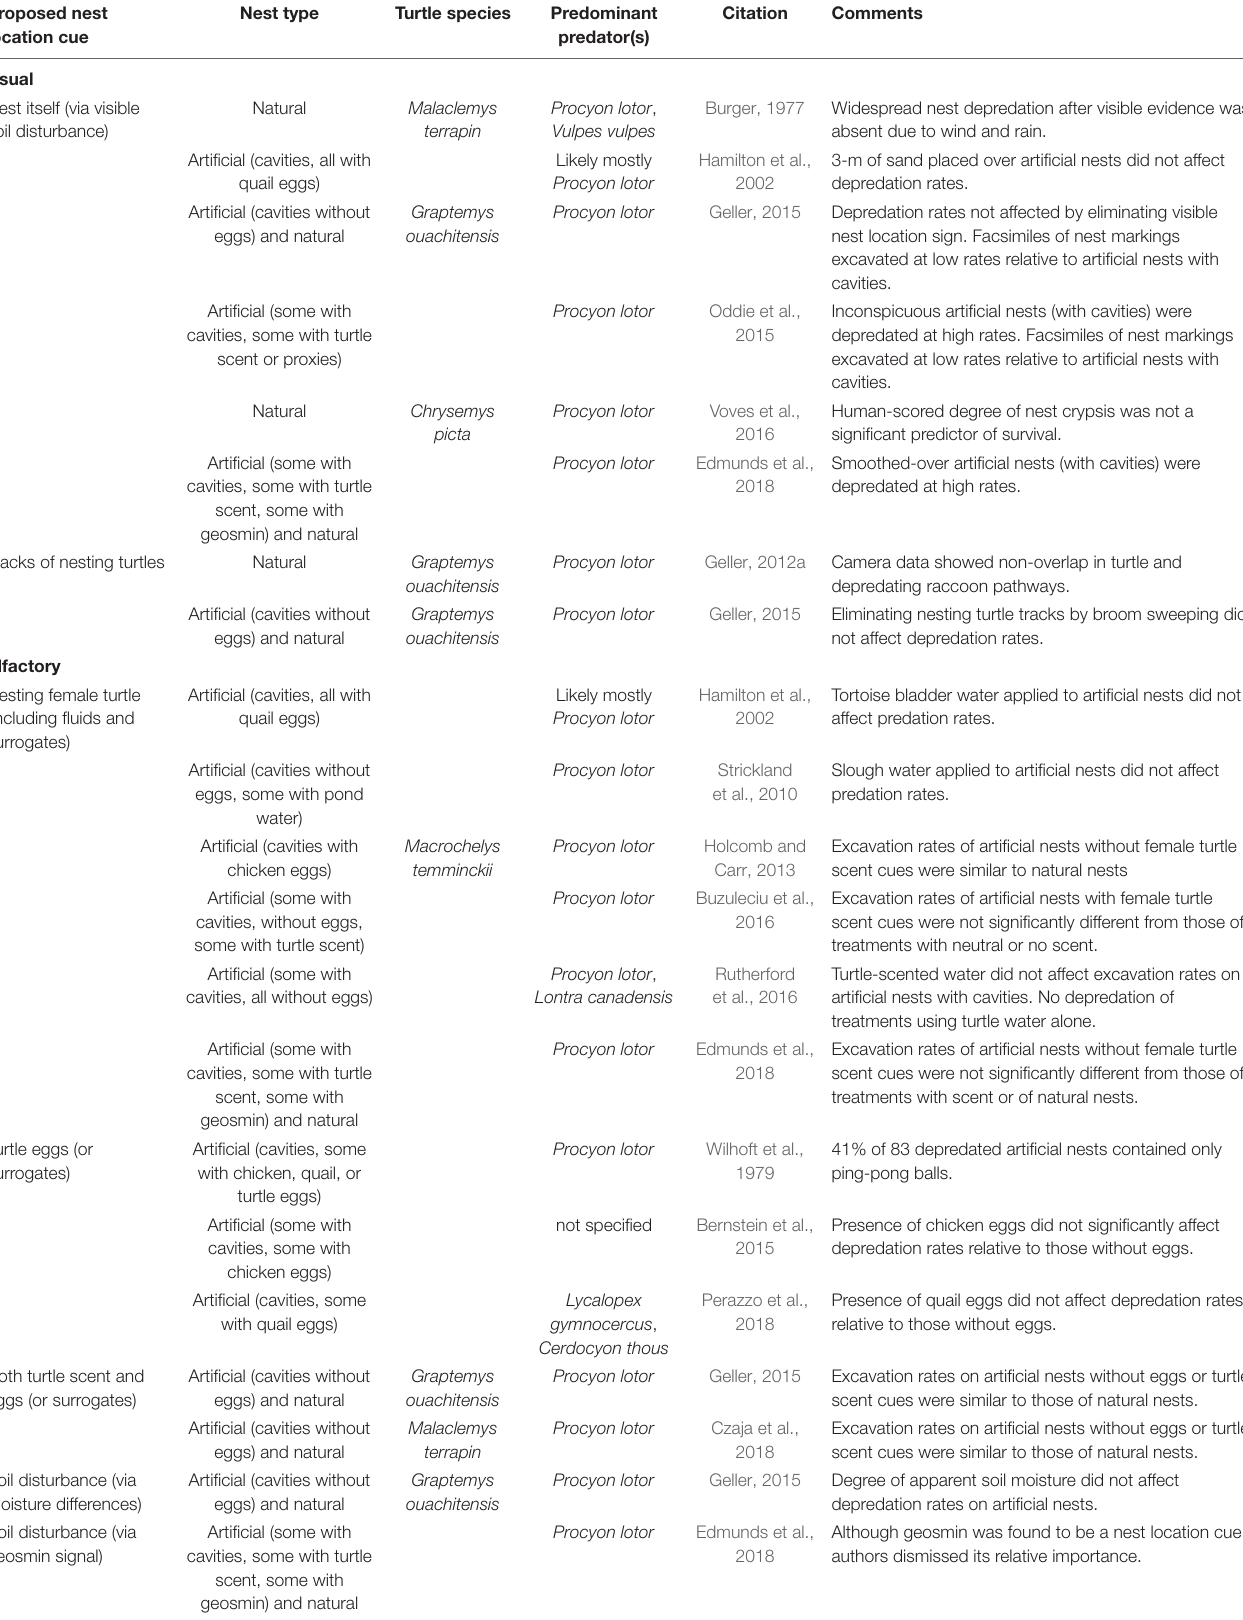
TABLE 3 | Papers discounting particular cues used by predators to locate freshwater turtle nests before the emergence